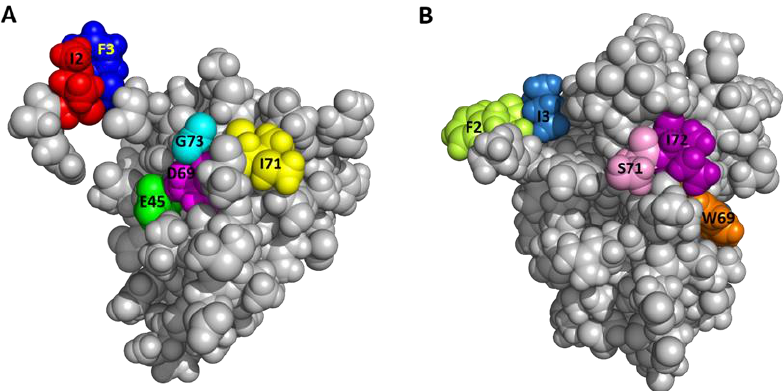
Figure 6. Close proximity of functionally important residues on the surface of the structure. The space-filling model for ( A ) Sco-CHH-L and ( B ) Pej-MIH with the residues possibly constituting receptor binding site are shown in color.